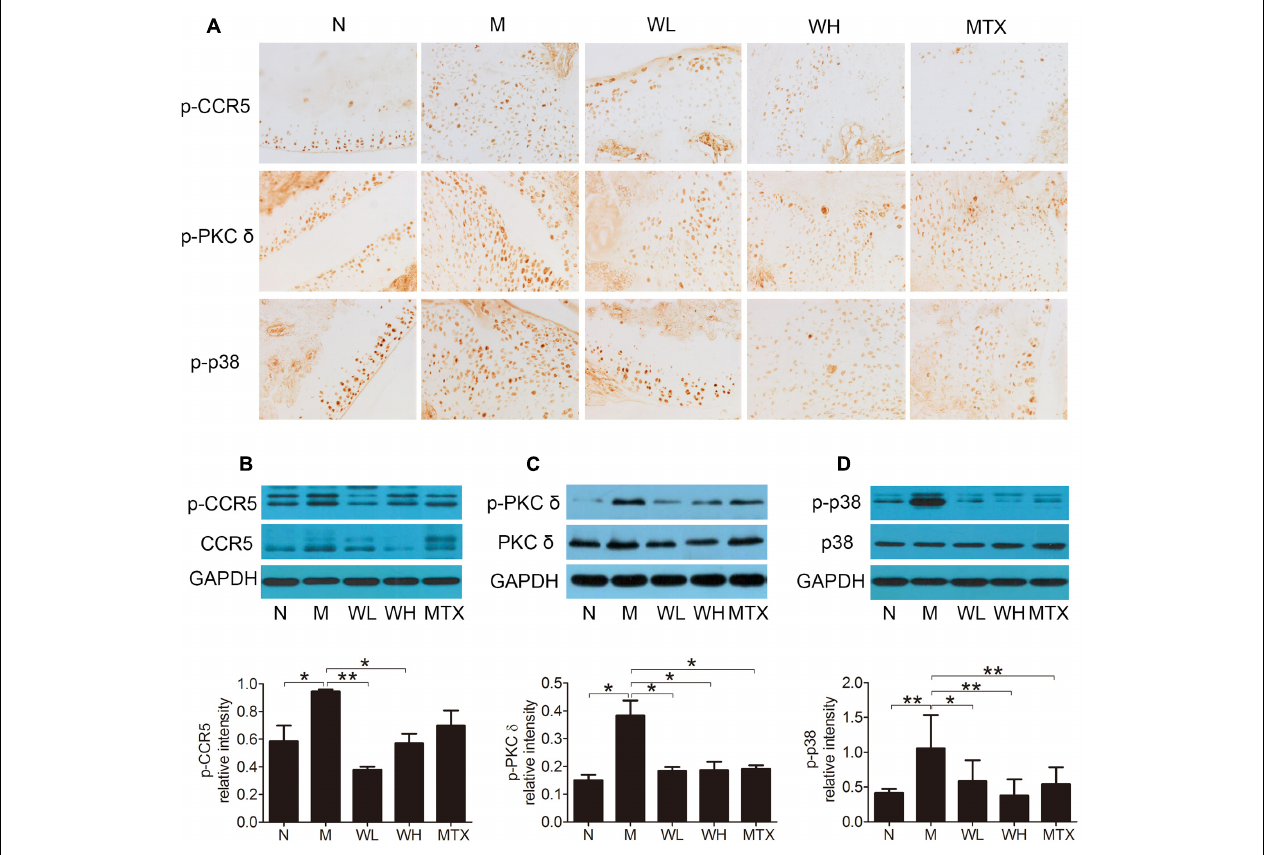
FIGURE 7 | Effects of WTD on level of total and phosphorylated CCR5, PKC δ , and p38 in ankle joints of CIA rats. (A) Immunohistochemistry findings of p-CCR5, p-PKC δ , and p-p38 in each group. Tissue sections from ankle joints in each group were stained with anti-p-CCR5, anti-p-PKC δ , and anti-p-p38 or isotype control Abs. The cells stained with each Ab were shown in brown. Original magnification 200 × . (B–D) Western blotting results of total and phosphorylated CCR5, PKC δ , and p38. ∗ P < 0.05, ∗∗ P <